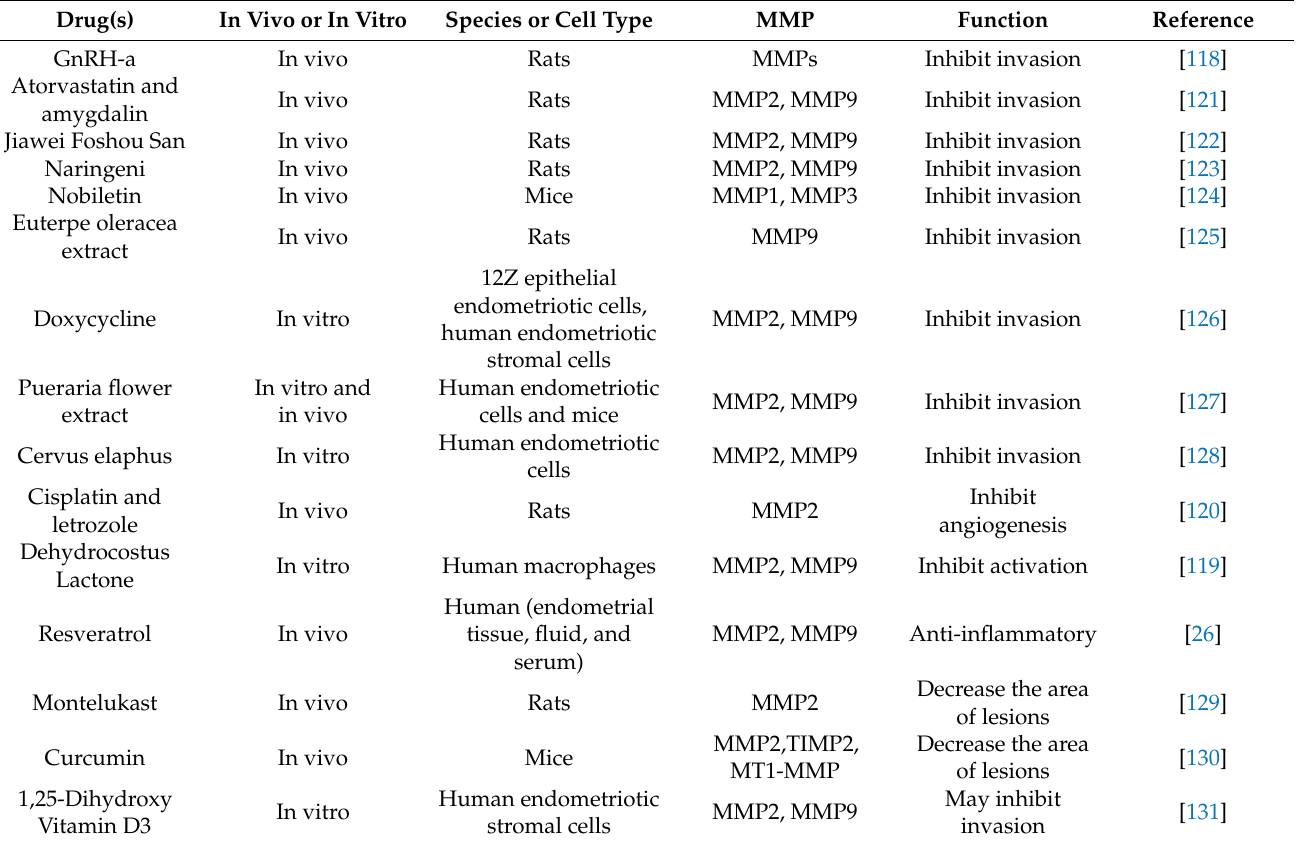
Table 2. MMP interventions for